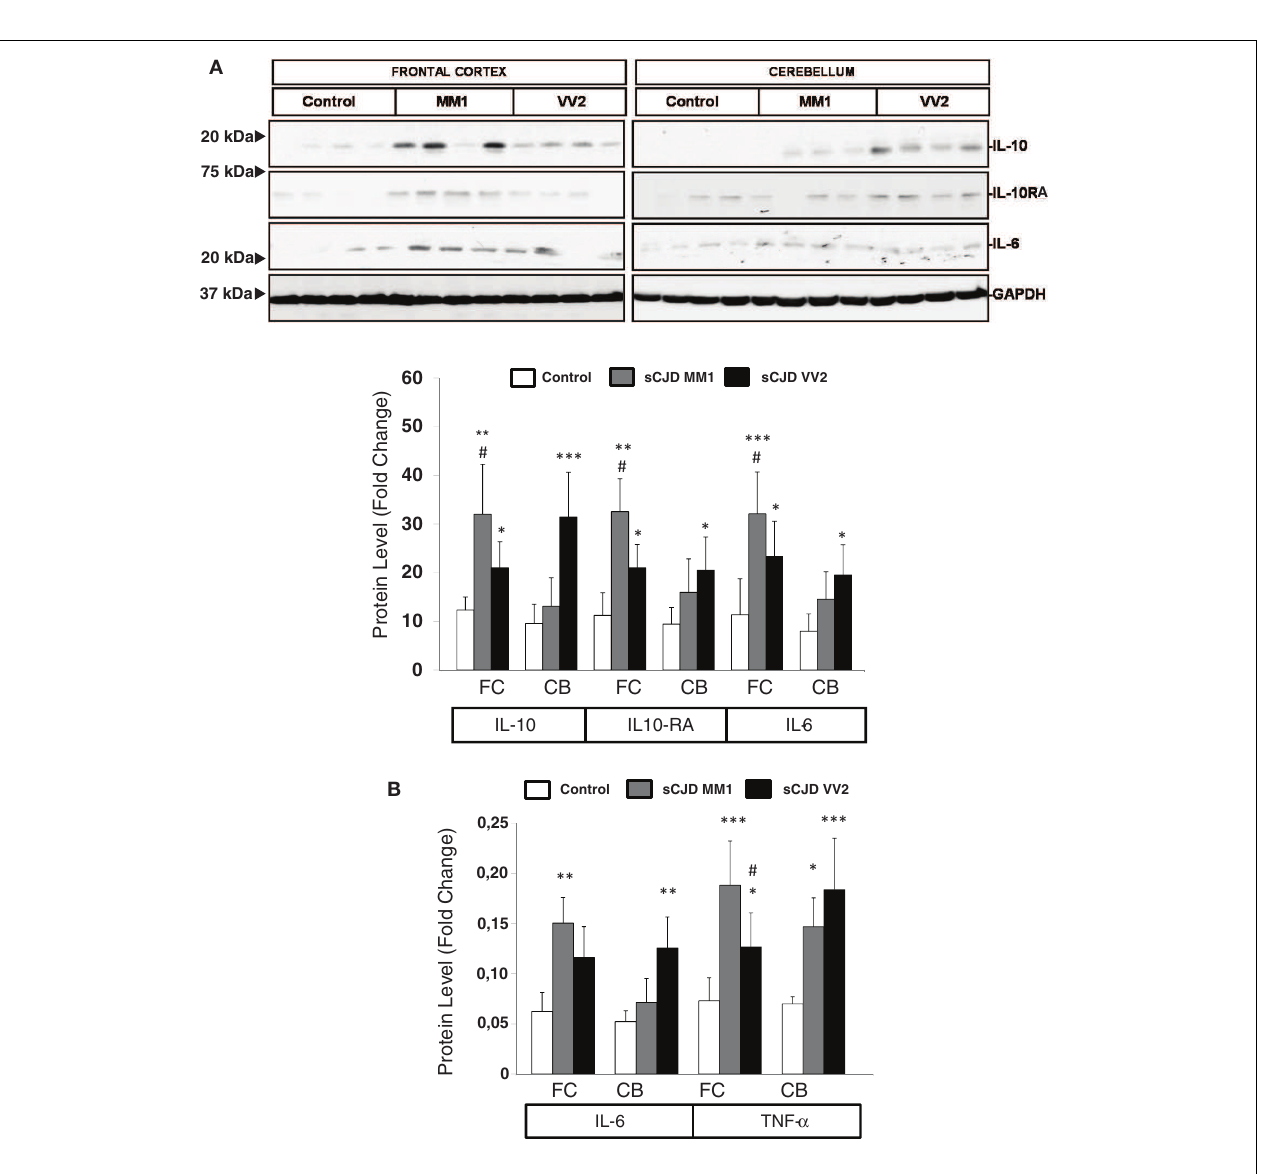
FIGURE 2 | Protein expression of immune mediators in sCJD is shown . (A) Western blot analysis of IL10, IL10RA, and IL6 in the frontal cortex and cerebellum of control, sCJD MM1, and sCJDVV2 cases. Four representative cases are shown. GAPDH immunostaining was used to normalize protein loading. Densitometry values of all the cases analyzed by western blot: control ( n = 15), sCJD MM1 ( n = 15), sCJDVV2 ( n = 15) show a significant increase in the expression of IL10, IL10RA, and IL6 in MM1 andVV2 samples. * p > 0.05, ** p > 0.005, *** p > 0.001: control